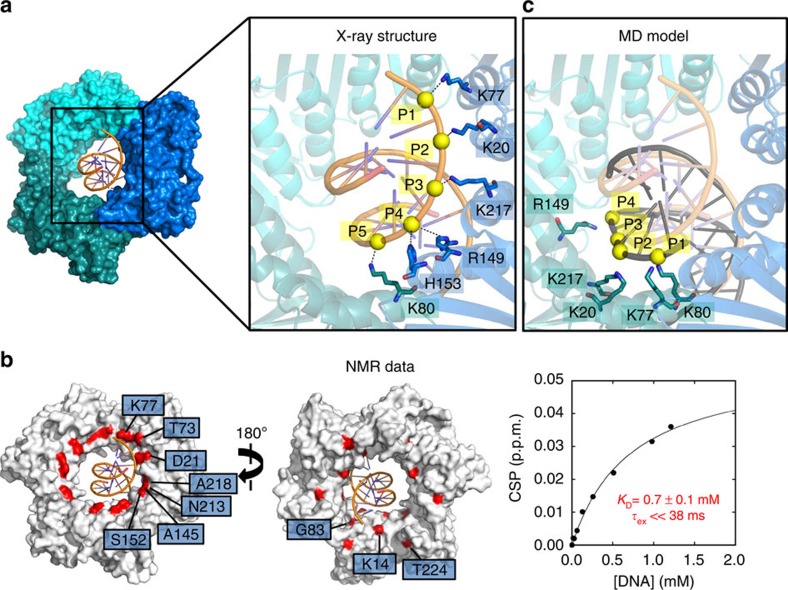
Structural basis of DNA recognition by human PCNA.(a) 2.8Å crystal structure of PCNA bound to a 10 bp DNA duplex. PCNA and DNA are shown in surface and ribbon representation, respectively. PCNA subunits are coloured in different shades of blue and DNA in orange. The expansion shows the complex in ribbon representation. Interacting PCNA side chains and DNA phosphates (interatomic side chain nitrogen—DNA phosphorus distance <5 Å) are shown as sticks and yellow spheres, respectively, and interactions as dashed lines (b) NMR analysis. Left: front- and back-face views of PCNA surface. PCNA residues whose amide chemical shifts are significantly perturbed by DNA are coloured red. The crystallographic position of DNA is shown in orange. The interacting region in the clamp channel overlaps with that seen in the crystal structure, whereas in the crystal, the side chains can be discriminated, in solution the perturbations involve the backbone amides. Right: chemical shift perturbation of the amide signal of PCNA residue T73 at different DNA concentrations. Fitting was performed using a single-site binding model. Extrapolated dissociation and exchange time constants are indicated. (c) Model interface from MD simulation. The crystallographic position of the DNA segment is shown in orange, whereas in black the DNA is shown in a position corresponding to the final state of the 100 ns MD simulation of the complex.